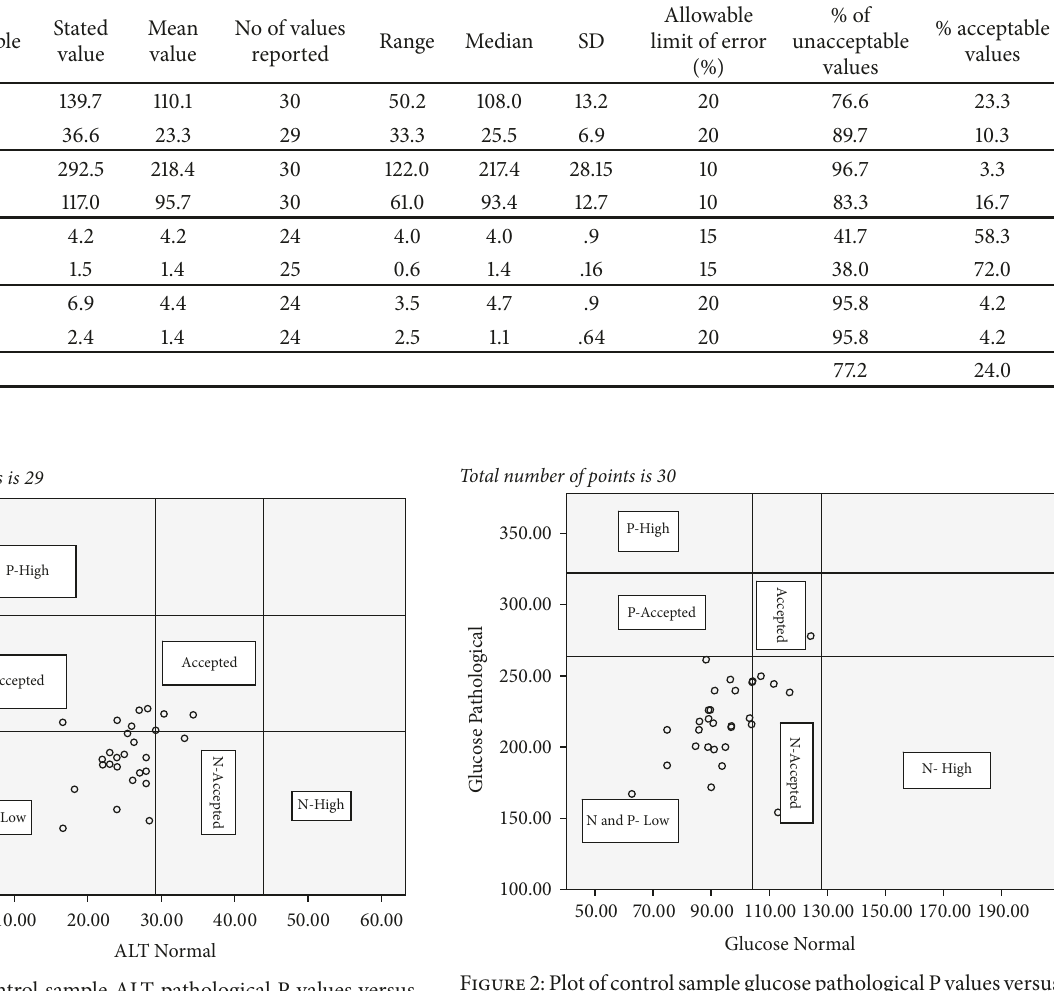
Figure 1: Plot of control sample ALT pathological P values versus control sample ALT normal N values for the total of 29 reported points. P: pathological; N: normal.